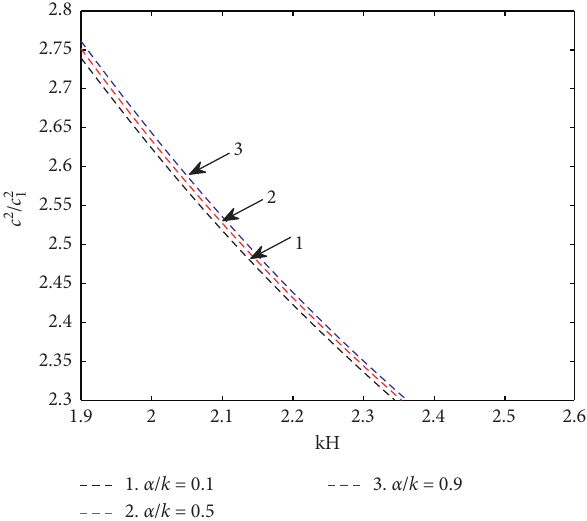
Figure 8: Model-I: effect of the heterogeneity parameters ( α / k ) under rigid mountain